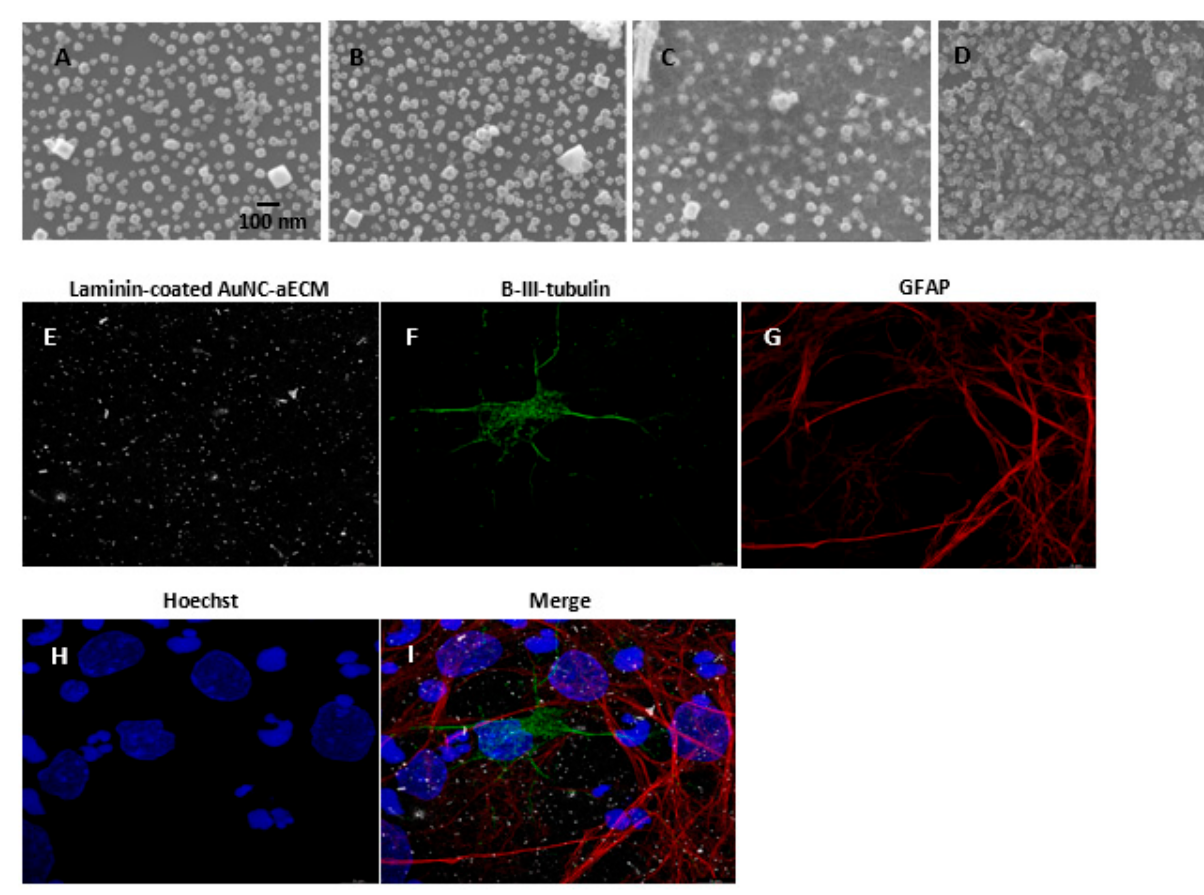
Figure 1. Characterization of AuNC-aECMs and laminin-coated AuNC-aECMs. ( A – D ) Scanning electron microscopy of AuNC-aECMs. The quantity of AuNCs can be controlled by reaction buffer solution and the concentration of AuNC colloidal solution ( A : 12.8 fmol, 32 AuNCs/ μ m 2 and B : 25.6 fmol, 54 AuNCs/ μ m 2 ). The AuNC-aECMs were coated with laminin ( C : 32 AuNCs/ μ m 2 and D : 54 AuNCs/ μ m 2 ). The cells growing on laminin-coated AuNC-aECMs (32 AuNCs/ μ m 2 ) were analyzed with immunostaining assay and fluorescent images were obtained using Leica—Lightning Light Laser Confocal Microscope SP8X ( E – I ). ( E ) Laminin-coated AuNC-aECM, ( F ) β -III-tubulin immunostaining (neuron marker), ( G ) Glial fibrillary acidic protein (GFAP) immunostaining (astrocyte marker), ( H ) Hoechst staining, ( I ) Merged image.